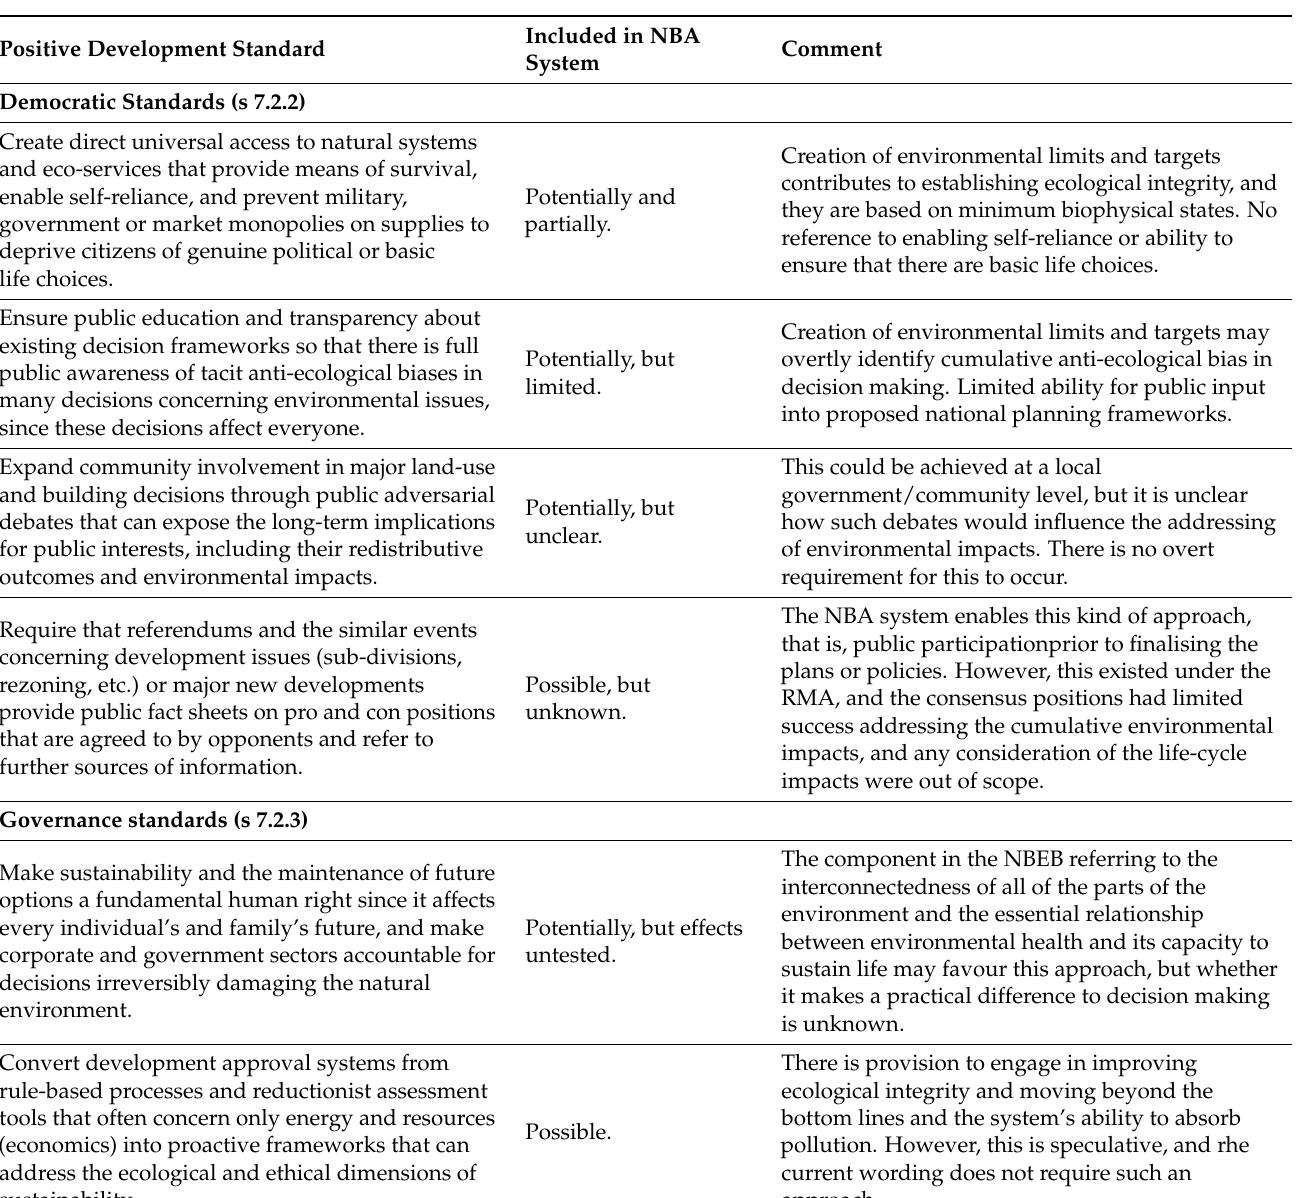
Table 1. Positive Development standards enabled, potentially addressed or not addressed by the proposed Natural and Built Environment Act, the Spatial Planning Act, and the Climate Adaptation Act (the NBA system). Section descriptions in column one are from Birkeland